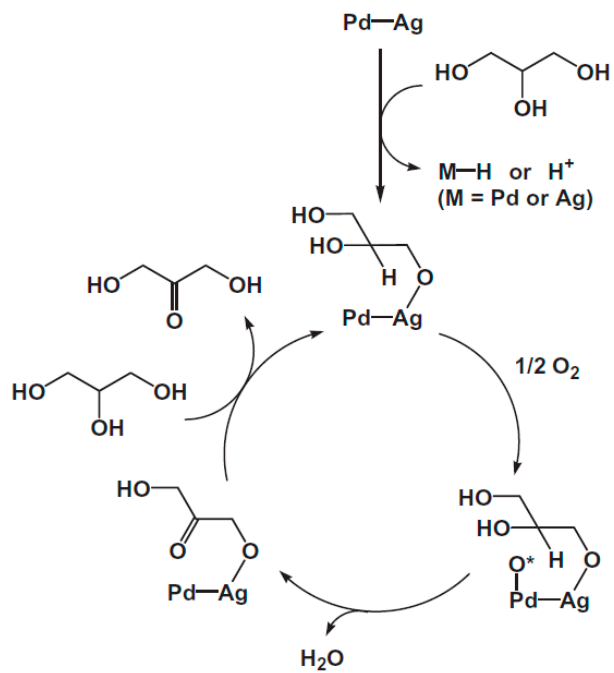
Figure 20. Proposed mechanism of glycerol oxidation over Pd–Ag/C. Reprinted with permission from reference [147]. Copyright 2013 Elsevier.